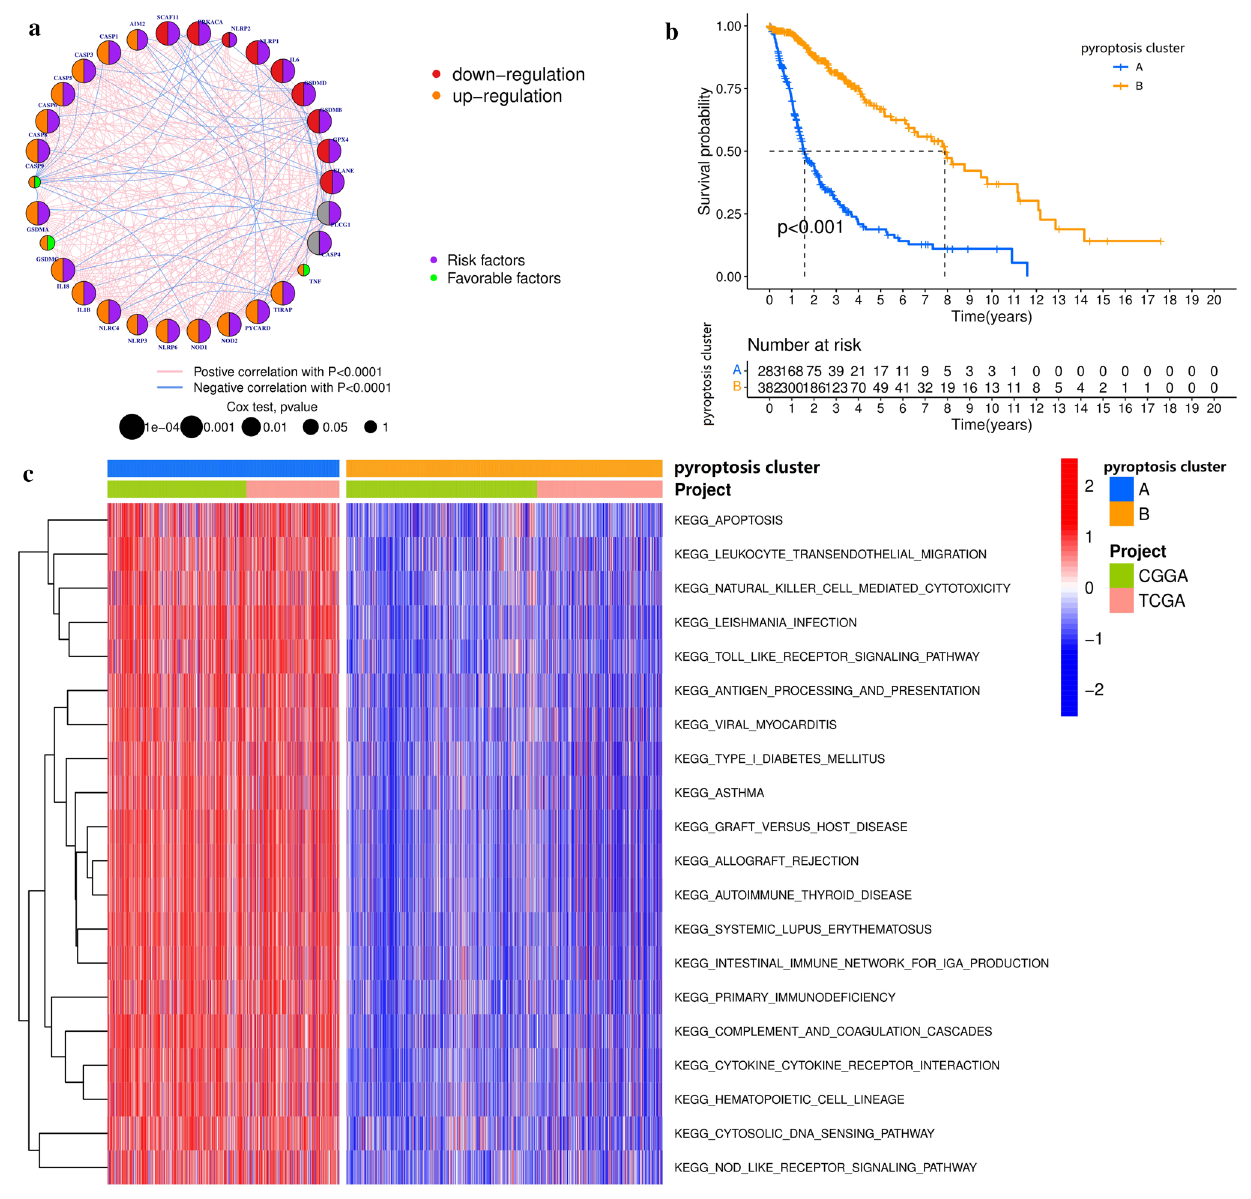
Fig. 2 Prognostic and biological characteristics of pyroptosis modification patterns. a The interaction between pyroptosis-related genes in glioma. The size of the circles represented the effect of each gene on prognosis, and the log-rank test range of values was p < 0.0001, p < 0.001, p < 0.01, p < 0.05, and p < 0.1. The lines linking related genes showed their interactions. Negative correlation, blue; Positive correla- tion, pink. Risk factors of prognosis were marked with purple; Favorable factors of prognosis were marked with green. The gene expression was upregulated or downregulated in the tumor marked orange or red, respectively. b The survival curves of the pyroptosis clusters were estimated by the Kaplan–Meier plotter ( p < 0.001, log-rank test). c Gene set variation analysis (GSVA) enrichment analysis showed distinct pyroptosis regulation patterns with different biological pathways activated. Visualizing biological processes by heatmap, activated path- ways, red; inhibited pathways,